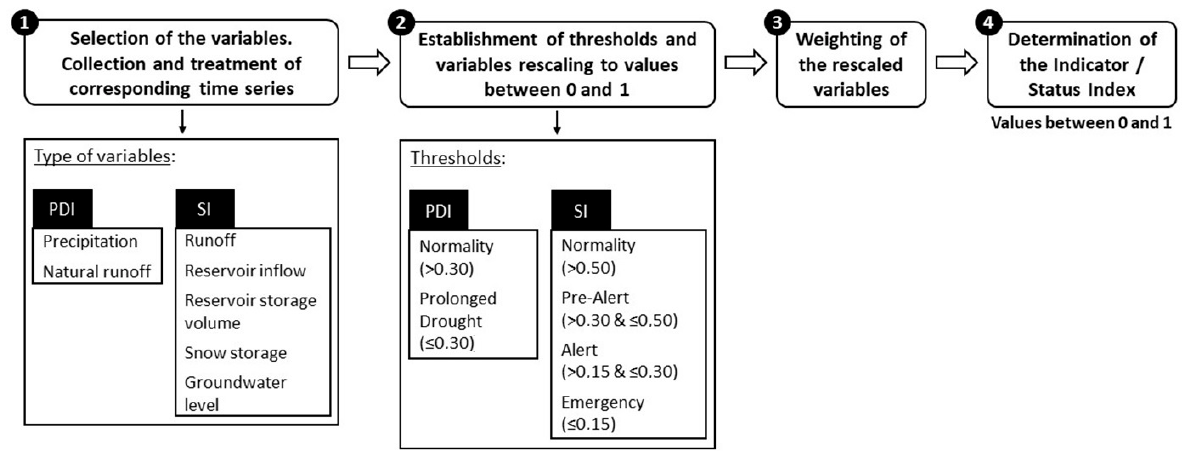
Figure 3. General methodology for the definition of both indicators (PDI and SI) (adapted from [20]). The procedure begins with the selection of the hydrometeorological variables for each defined territorial unit of analysis. For the PDI, two types of variables may be various types, including runoff, reservoir inflow, reservoir storage volume, snow storage, corresponding standardized indices (e.g., SPI).